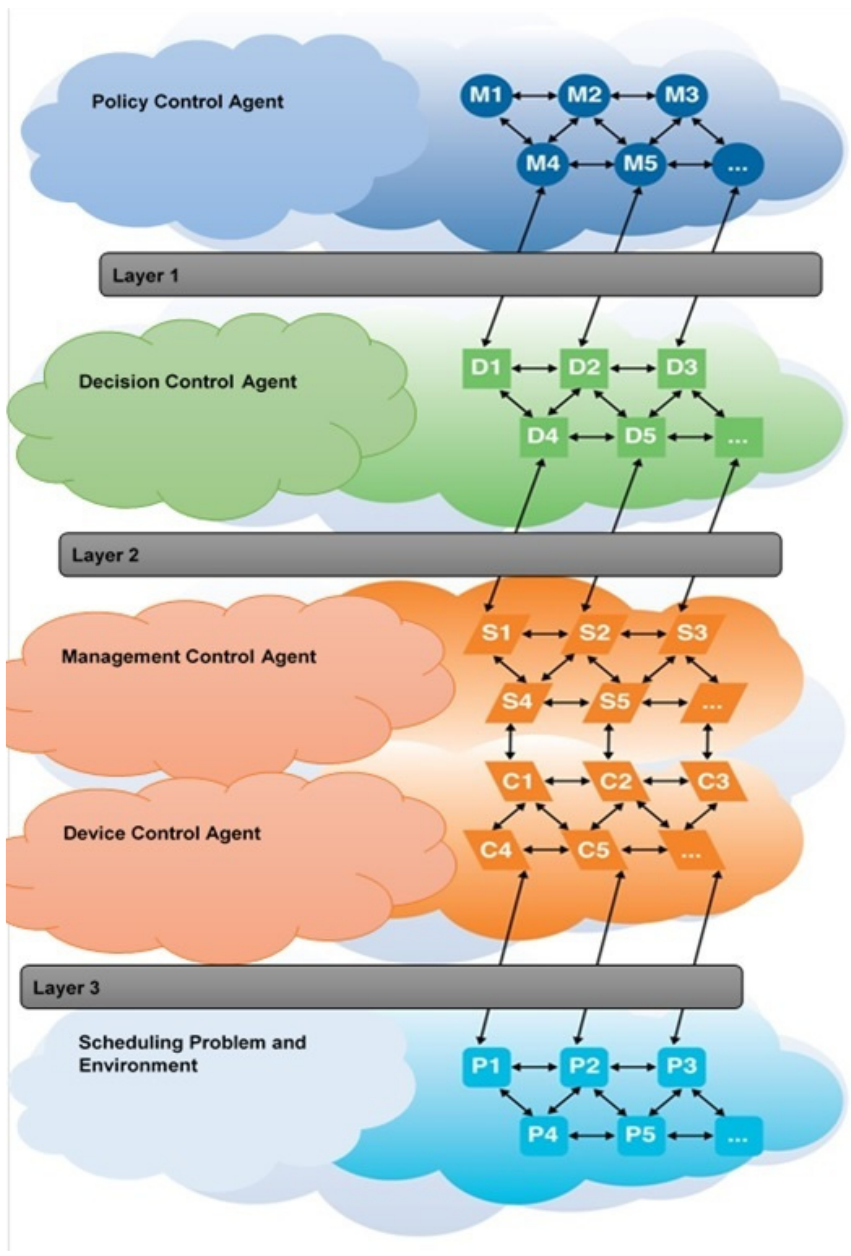
Figure 8. Policy Control Agent in Microgrid.